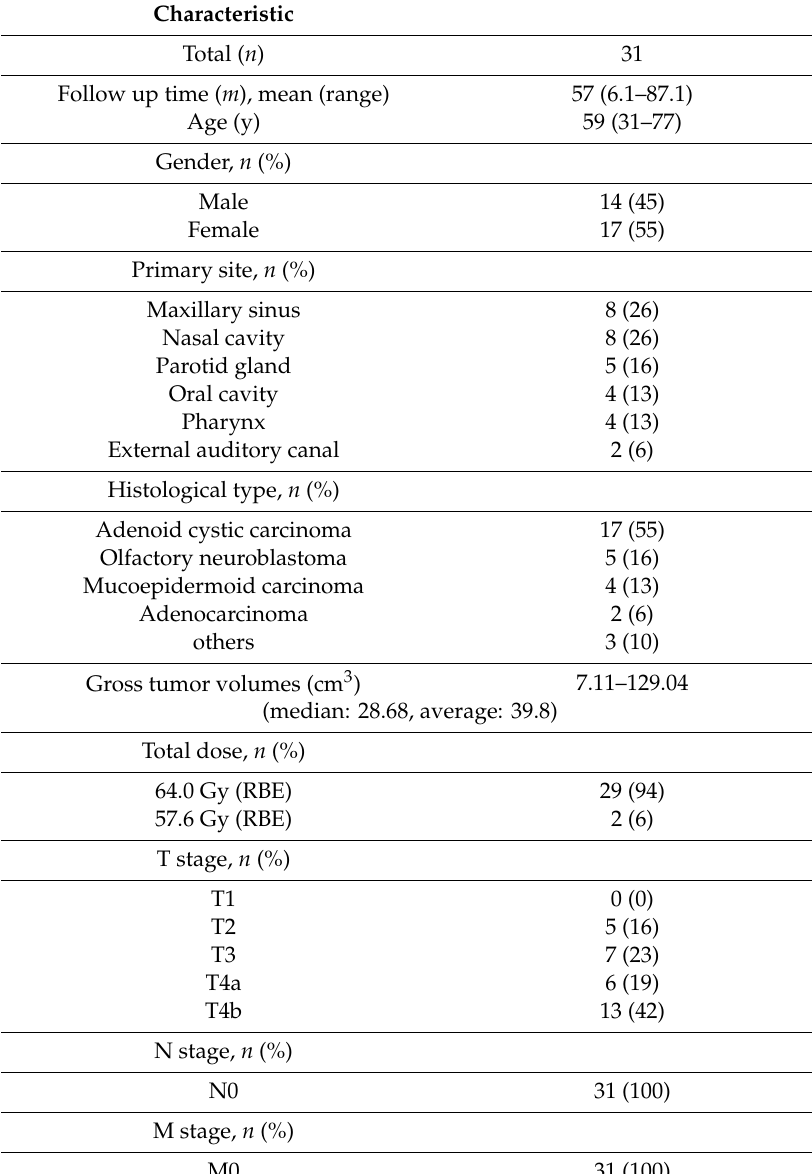
Table 3. Patient and tumor